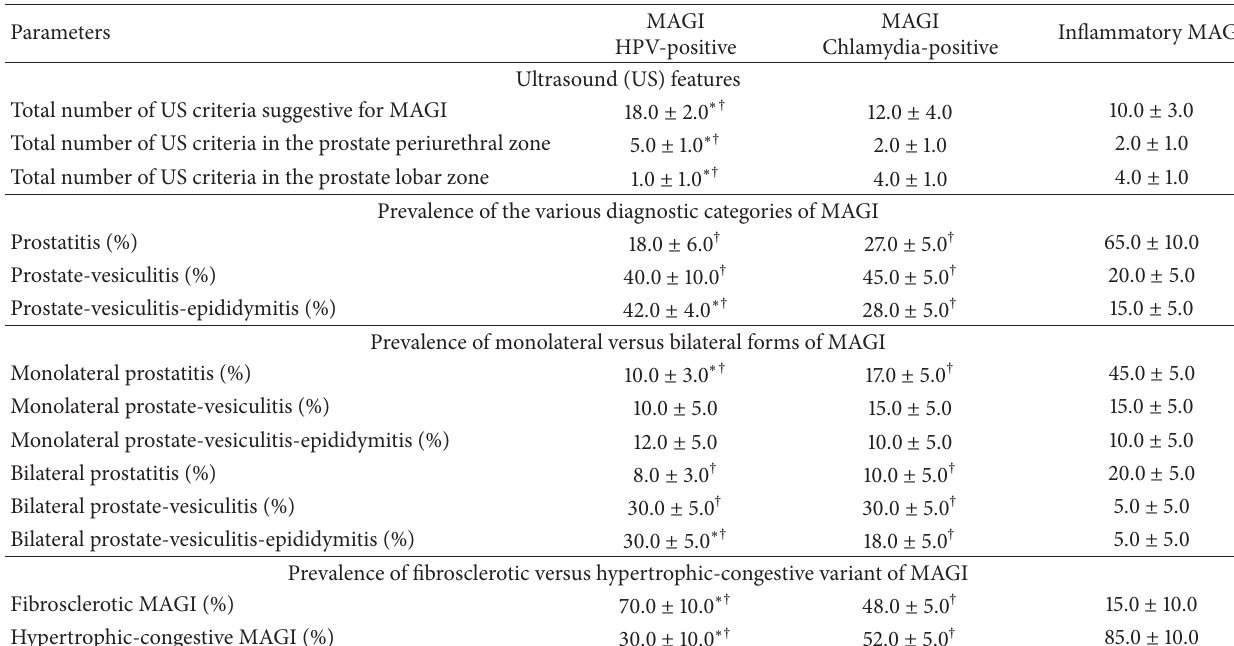
Table 3: Ultrasound features in the three groups of patients with male accessory gland infection/inflammation (MAGI) enrolled in this study. Parameters Total number of US criteria suggestive for MAGI Total number of US criteria in the prostate periurethral